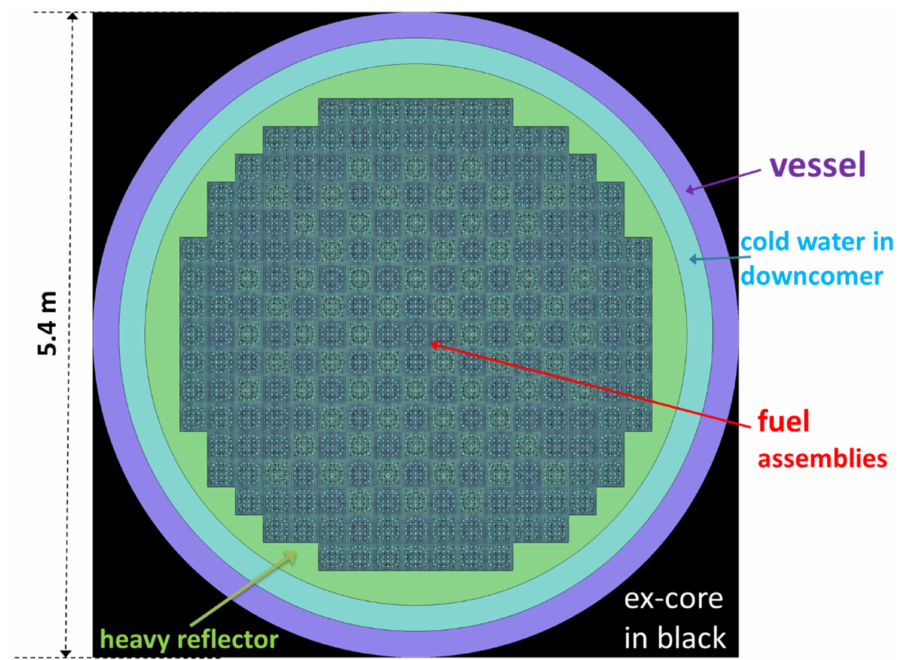
Figure 2. Evolutionary Pressurised Water Reactor (EPR) 3D full-core geometry specified using Serpent (radial view at the mid-plane of the